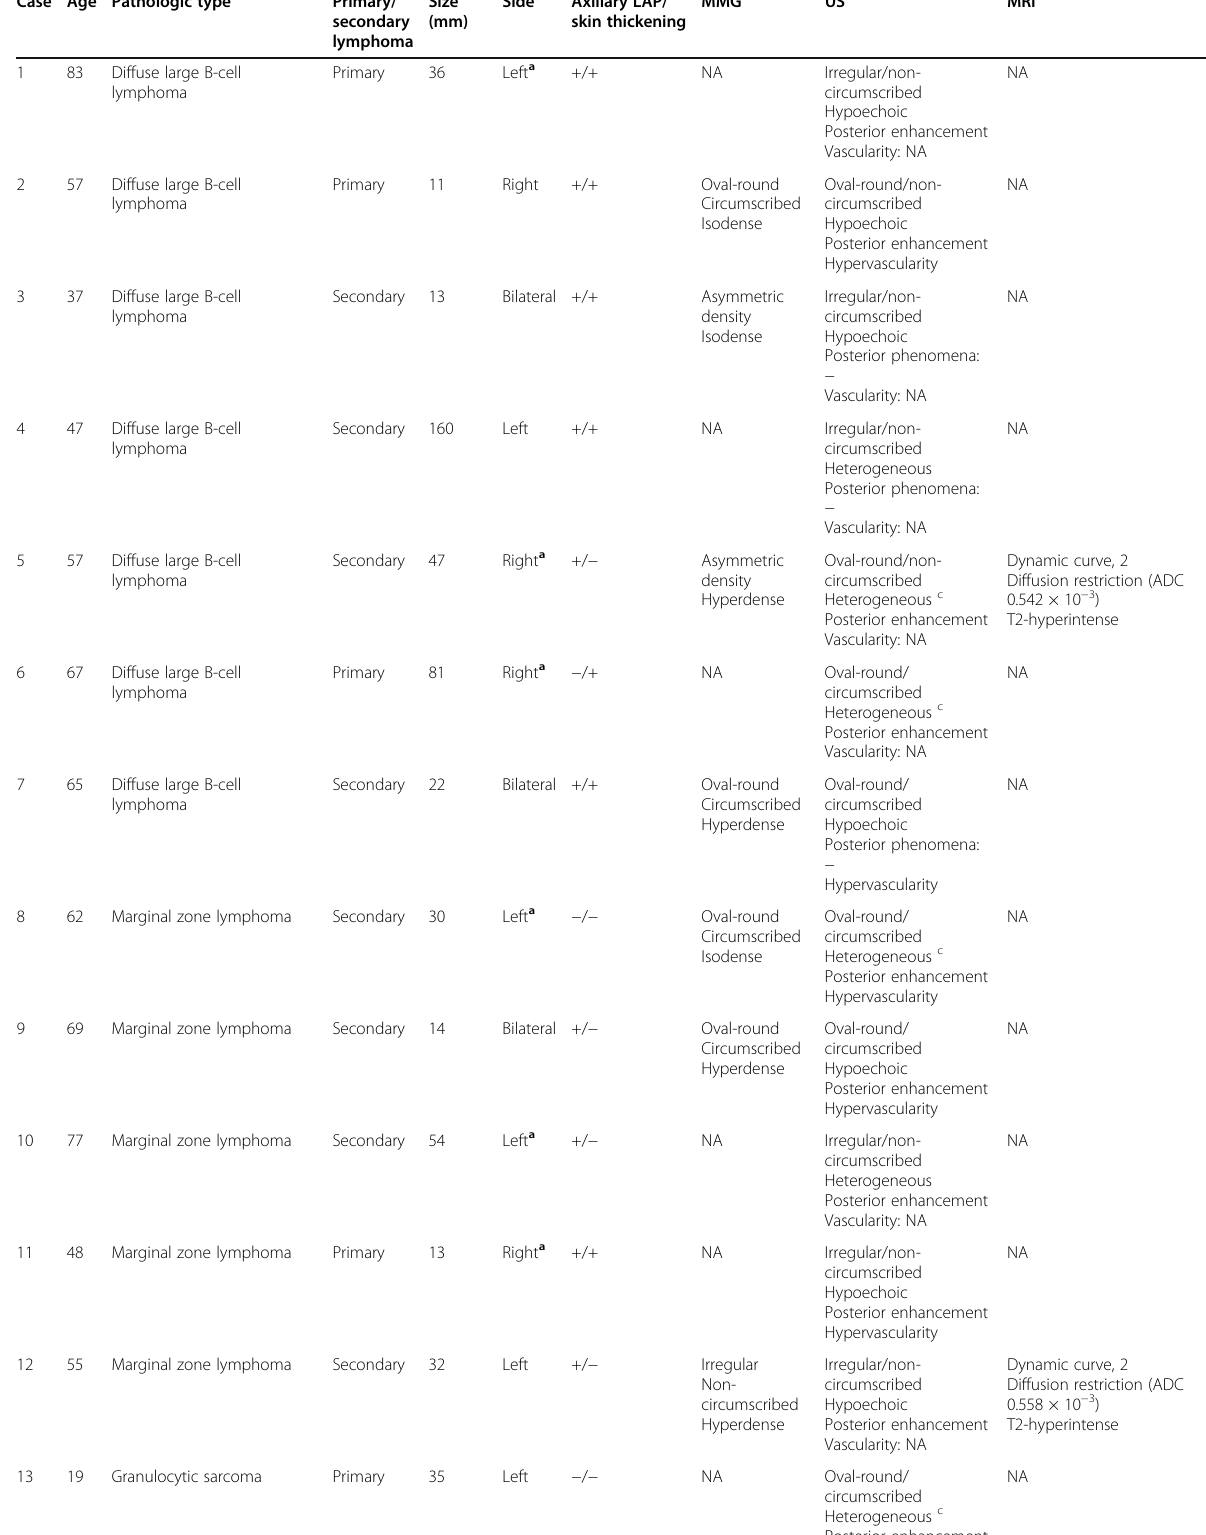
Table 1 Clinical and radiological findings of 20 patients with breast involvement of hematological malignancies Case Age Pathologic